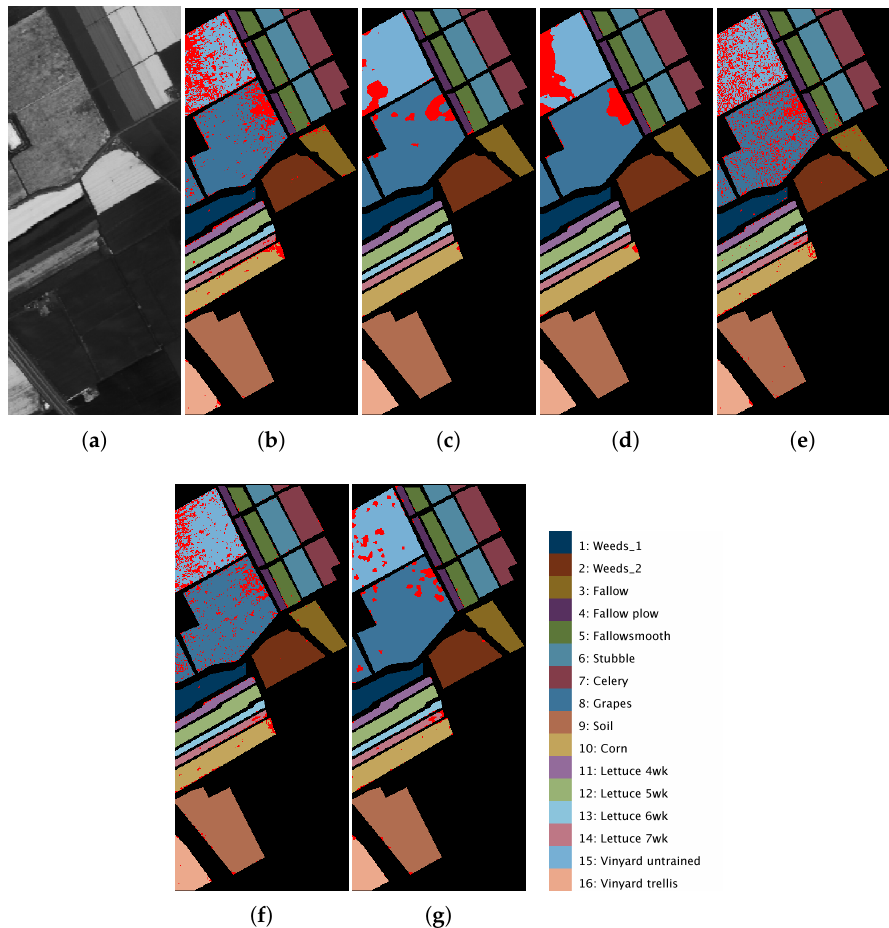
Figure 14. 2D angular transformation of the original hyperspectral image ( a ) and the results of the application of MLR ( b ); ppMLR ( c ); MLRpr ( d ); CRNN ( e ); SVM ( f ); and ECAS-II-SVM ( g ) classification methods to the Salinas scene. Misclassified pixels are marked with red dots. The classification methods have been trained using 10% of the samples of each class. Table 3. Class specific accuracies (%) for the raw SVM and the ECAS-II + SVM algorithm in the case of segmenting the Pavia, Indiana and Salinas